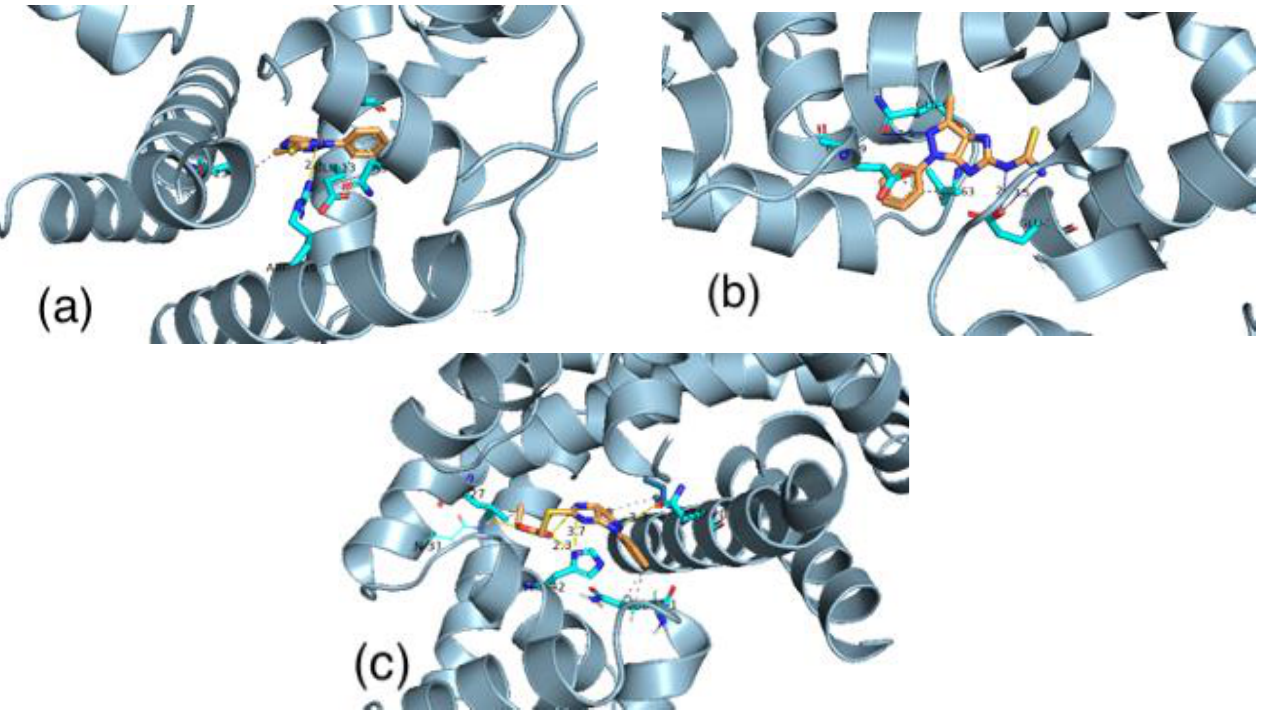
Figure 8. The binding of ligand (1) ( a ) ligand (2) ( b ) and ligand (3) ( c ) with the active site of Staphylococcus epidermidis.